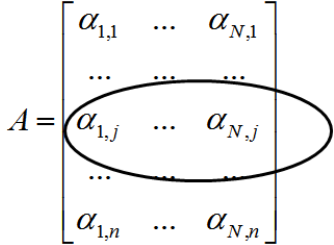
Figure 1. Row structure in MMV